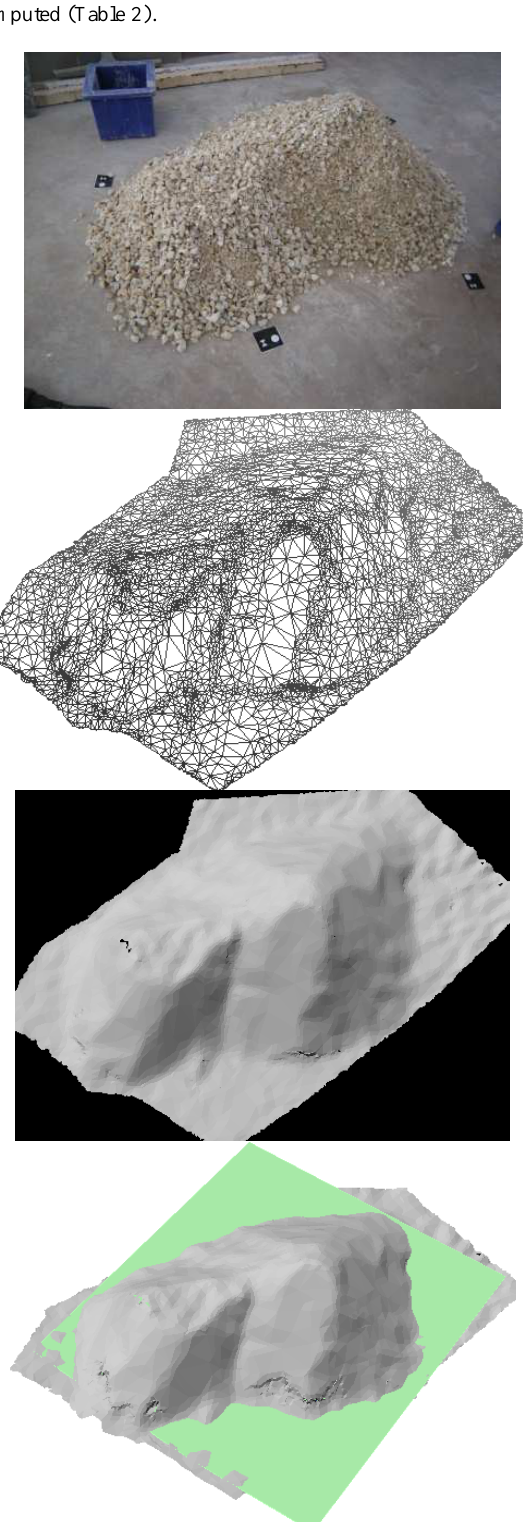
Figure 4. The triangulated and mesh models of the gravel